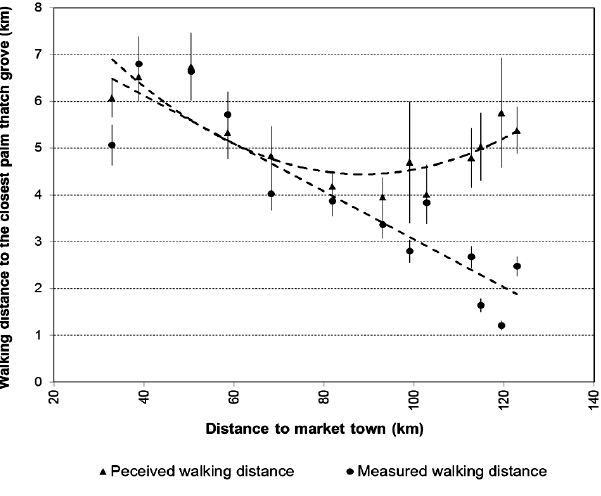
Fig. 2 . Mismatch between measured and perceived walking distance to the closest thatch palm groves. The dashed lines show the fitted regression models. The bars indicate the perceived and measured standard error of the mean walking